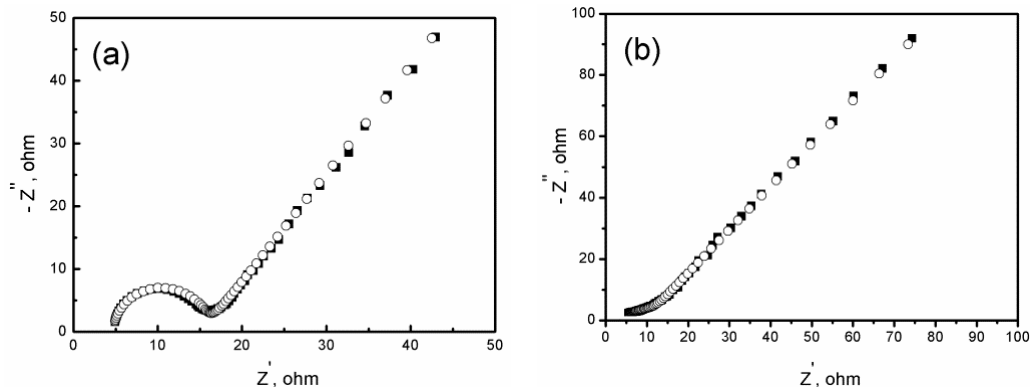
Figure 10. Nyquist diagrams for CaP electrodeposition on ( a ) the top and ( b ) bottom surface of SLM-Ti scaffolds at deposition time of 3000 s. ■■■: experimental data and ○○○: fitting result.